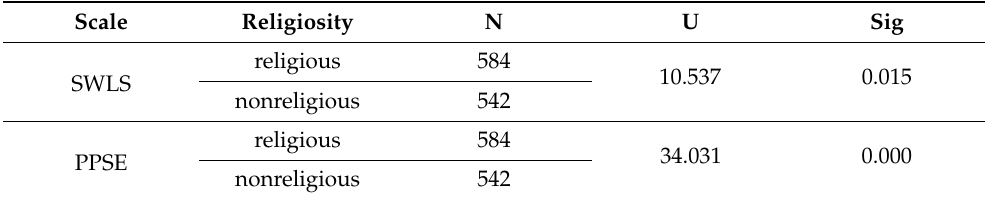
Table 2. Differences between well-being (SWLS) and experience of pastoral and psychological service (PPSE) score based on non/religious affiliation in the Czech health population. Scale Religiosity N U Sig religious 584 10.537 SWLS 542 religious 584 PPSE